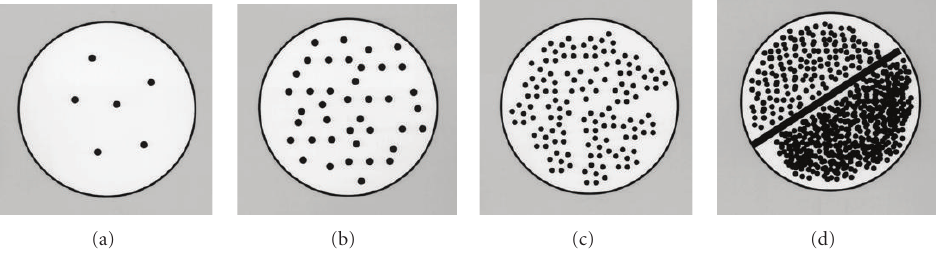
Figure 2: Fungal growth intensities: (a) (+)—mild growth; (b) (++)—intermediate growth; (c) (+++)—intensive growth; (d) (++++)— abundant (confluent) growth.